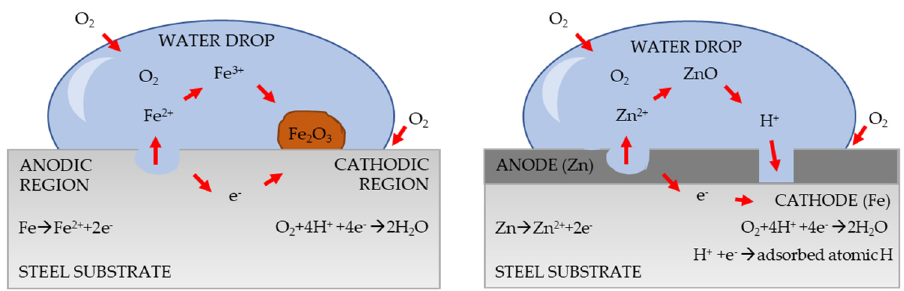
Figure 3. Hydrogen involving reactions in naked ( left ) and zinc coated ( right ) steel in contact with water.